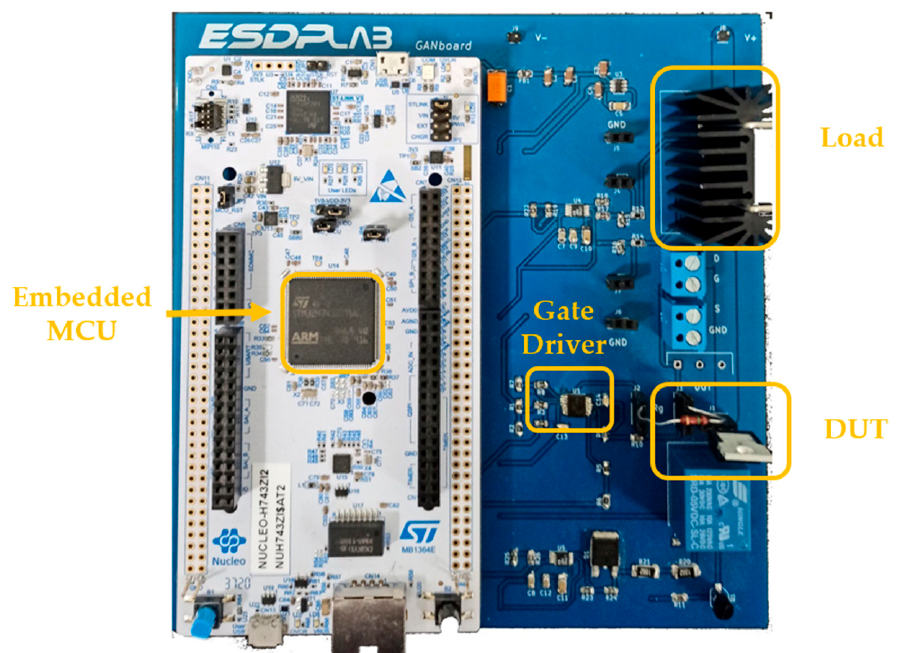
Figure 4. Embedded measurement system board: Embedded MCU, Gate Driver, DUT with gate resistance, Load.